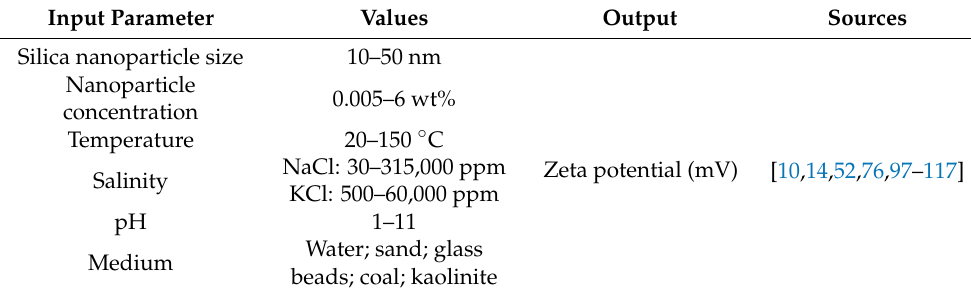
Table 1. Zeta potential data